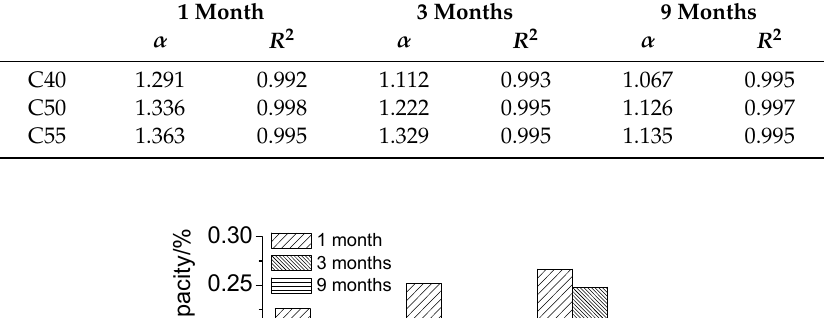
Table 4. Slope ( α ) and correlated coefficient ( R 2 ) of chloride binding isotherms. 1 Month